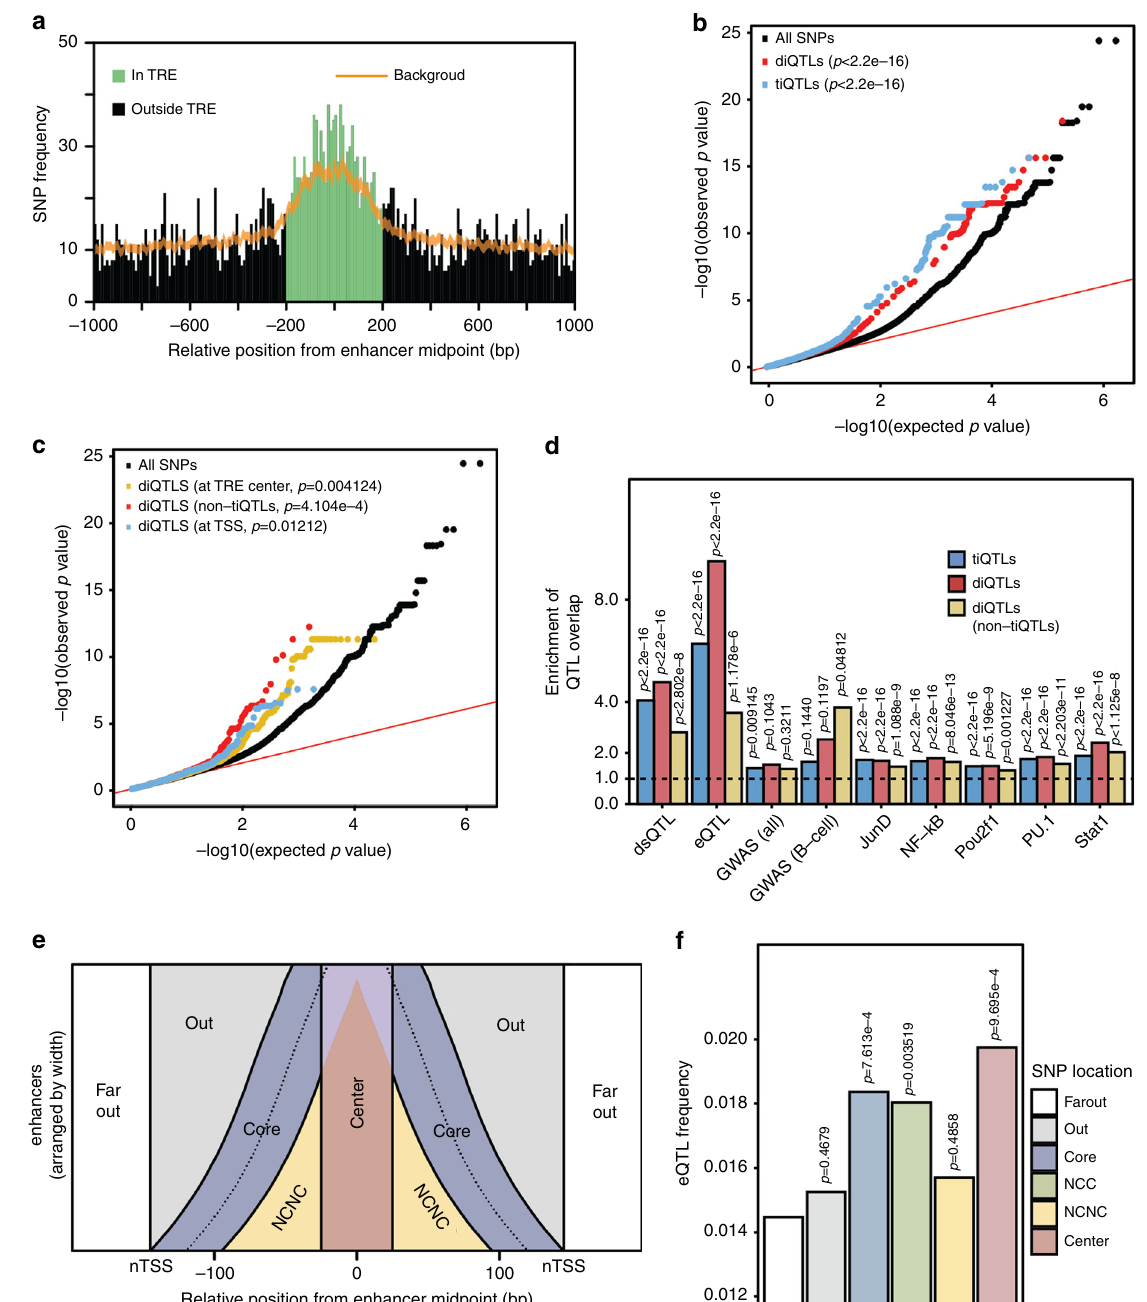
Fig. 5 ti- and diQTLs at enhancers associate with changes in gene expression. a eQTLs are enriched at enhancers. A histogram of QTL density around enhancer midpoints with the expected background distribution with 99% con fi dence interval (sampled from all SNPs in the same region) shown in orange. b QQ plot of all p -values for each SNP group in eQTL discovery analysis. P -values use two-sided Kolmogorov – Smirnov test comparing to the all SNP distribution. c As in b for subgroups of diQTLs. Exact p -values are p = 0.0041, p = 4.1 × 10 − 4 , and p = 0.012 respectively. d Enrichment of ti- and diQTLs in tTREs (±200 bp from center) containing other QTL types. Enrichment is computed compared to all SNPs in the same region. Overlap of QTL and background are compared for each bar with two-sided Fisher ’ s exact test. Exact p -values are p = 2.8 × 10 − 8 , p = 1.2 × 10 − 6 , p = 0.32, p = 0.048, p = 1.1 × 10 − 9 , p = 8.0 × 10 − 13 , p = 1.2 × 10 − 3 , p = 2.2 × 10 − 11 , and p = 1.1 × 10 − 8 for diQTL (non-tiQTLs) across categories respectively, p = 5.2 × 10 − 9 , 0.10, and 0.12 for diQTLs compared with POU2F1 , all GWAS, and B-cell related GWAS respectively, p = 0.0091 and p = 0.14 for tiQTLs compared with all GWAS and B-cell GWAS respectively, and p < 2.2 × 10 − 16 for all other indicated p -values. Source data are provided as a Source Data fi le. e Diagram explaining the separation of candidate enhancer tTREs into functional regions. NCNC: non-center, non-core. f eQTL frequency in different enhancer regions. NCNC: non- center-non-core, NCC: non-center-core (core area does not overlap with center area). Each colored bar is compared to Far Out in a two-sided Fisher ’ s exact test. Exact p -values are p = 0.47, p = 7.6 × 10 − 4 , p = 0.0035, p = 0.49, and p = 9.7 × 10 − 4